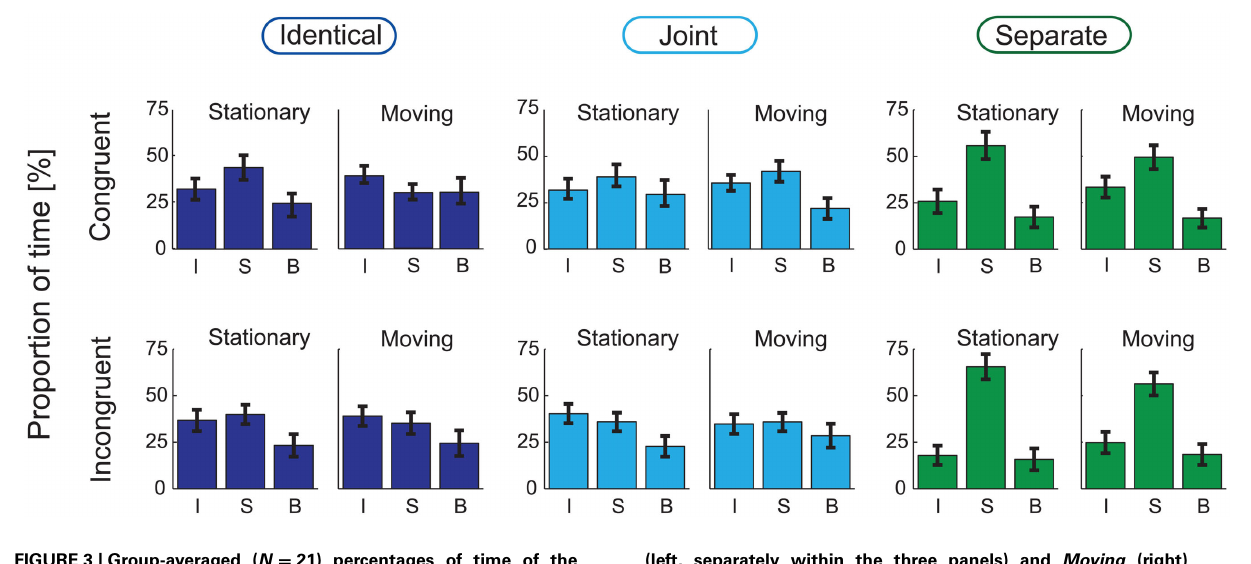
(left, separately within the three panels) and Moving (right) conditions and for the Congruent (top row) and Incongruent (bottom) conditions. Error bars show the standard errors of mean.